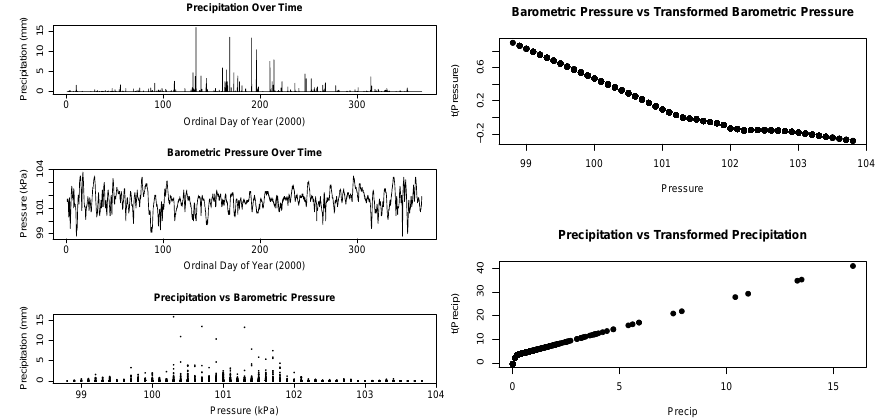
Fig. 2. Second example illustrating the application of the ACE algorithm to input data ( left – x over time, y over time, x vs. y ), and the resulting point pair output ( right – top: [ x,f (x) ] ; bottom: [ y,g(y) ]